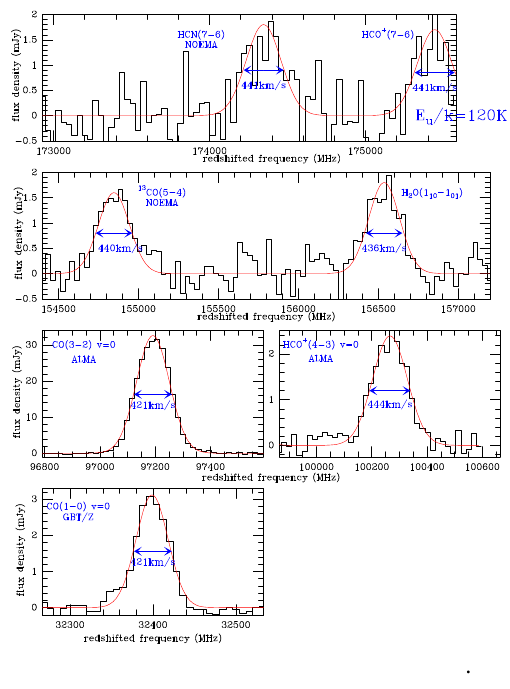
Figure 2. ALMA 3-mm spectrum of the Cloverleaf Quasar. Lower scale is redshifted frequency and upper scale rest frequency. Ordinate is line flux density in janskys. The red curve shows Gaussian fits to the detected lines. For the weakest lines, the Gaussian FWHM was set equal to that of the strongest nearby lines – see Fig. 4.